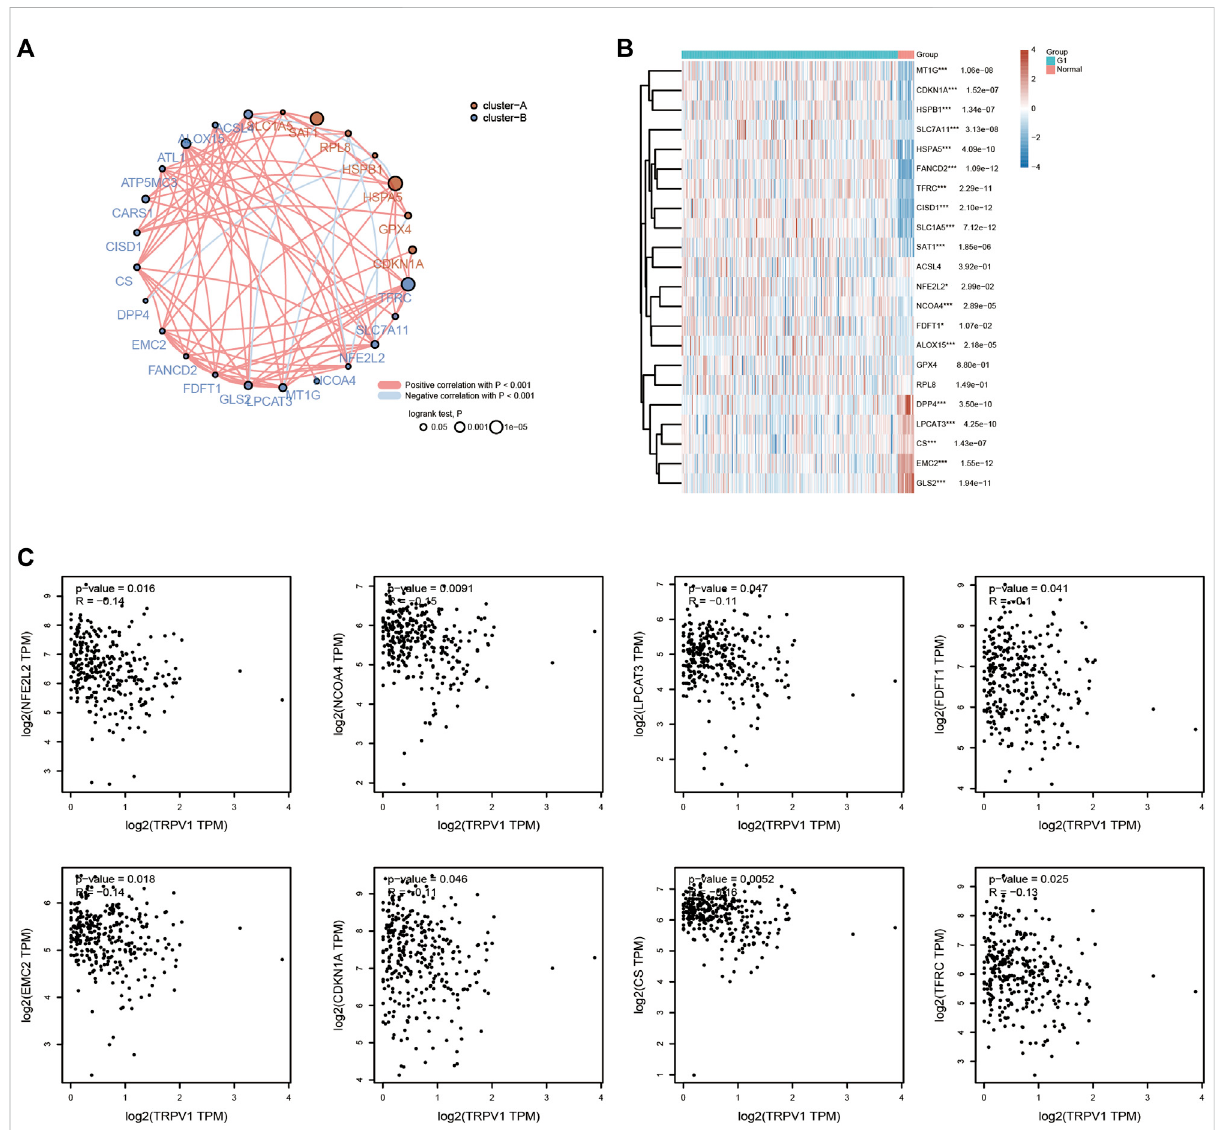
Effects of TRPV1 on ferroptosis in CSCC. (A) Correlation: Circles represent the ferroptosis-related genes, line represents the relationship between the ferroptosis-related genes. (B) Heatmap: the heatmap of ferroptosis related gene expression. (C) Effects of TRPV1 on the ferroptosis- related genes including NFE2L2, NCOA4, LPCAT3, FDFT1, EMC2, CDKN1A, CS, and